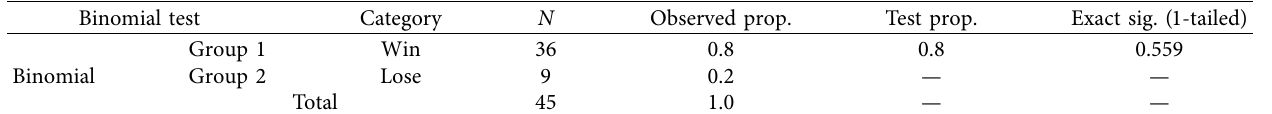
Table 5: Output table of SPSS software regarding the